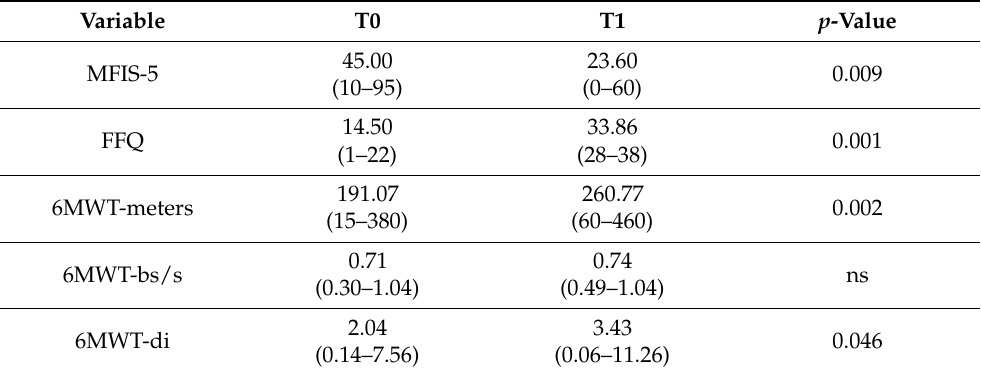
Table 2. Physical activity parameters and adherence to the recommended diet before (T0) and after (T1) the B-HIPE program. Median, interquartile range, and statistical significance are shown. ns: not significant; Wilcoxon test.